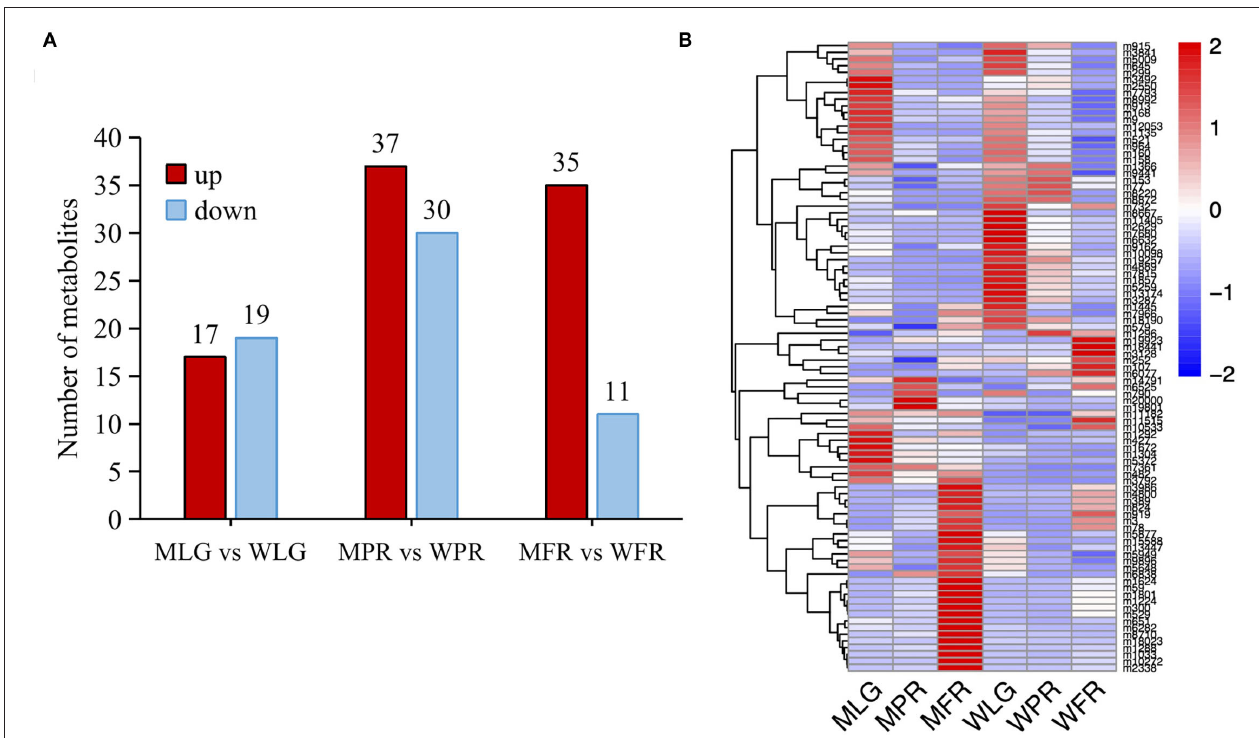
FIGURE 3 | The differentially accumulated flavonoids in WT and MT samples. (A) Comparison of up- and down-regulated flavonoids of different developmental stages in two varieties. (B) Heatmap showing the intensities of all the DA flavonoids. The heatmap was represented by the z-score values of the mean peak area of 6 biological replicates.